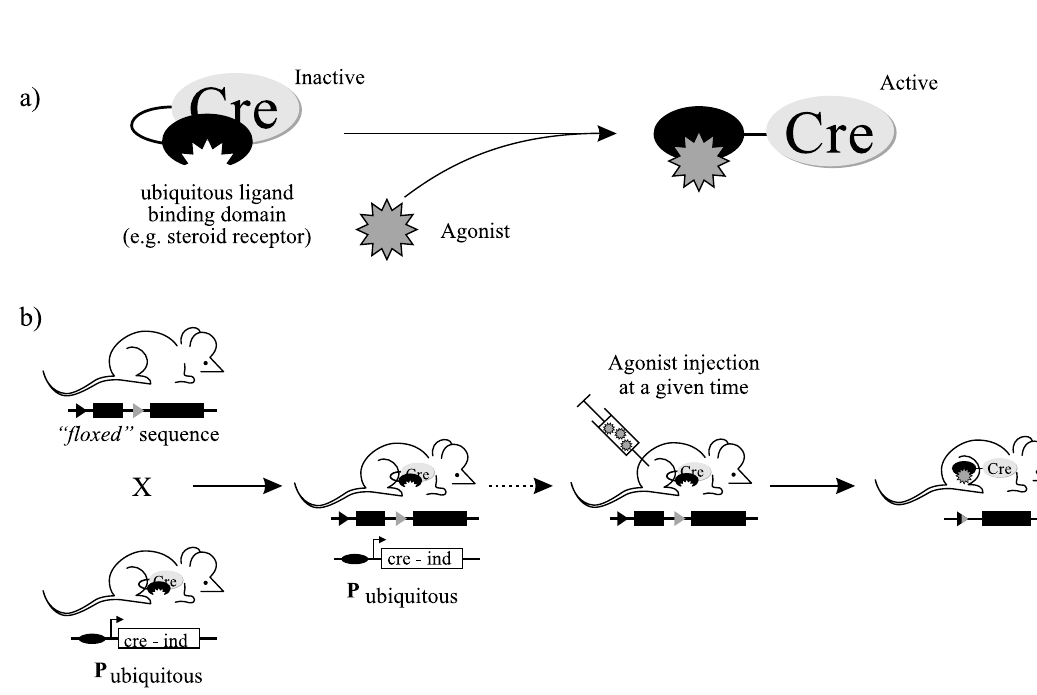
Fig. 6 – The Cre/ loxP system and inducible mutations. (A) This strategy relies on the use of a fusion protein between the Cre recombinase and the ligand binding domain of a steroid hormone nuclear receptor. In the absence of a ligand, recombinase activity is null or very weak, whereas in the presence of a ligand it is rapidly induced. The ligand-binding domain is a modified version which presents reduced affinity for the natural ligand (progesterone, estrogen) but increased in the case of synthetic analogs (RU486, tamoxifen). The activity of this inducible Cre recombinase (Cre-ind) is therefore controlled by administration of the agonist. b) This strategy can be applied in vivo, in animals carrying not only a ‘‘floxed’’ sequence but also a transgene coding for Cre-ind controlled by a promoter (ubiquitous here). Deletion of the ‘‘floxed’’ sequence is dependent on the administration to this mouse of an agonist. It therefore provides a way to control the time of the appearance of a targeted genetic modification. If, instead of an ubiquitous promoter, a specific promoter is used, then the appearance of the modification can be controlled both in terms of time and localization (tissue or cell